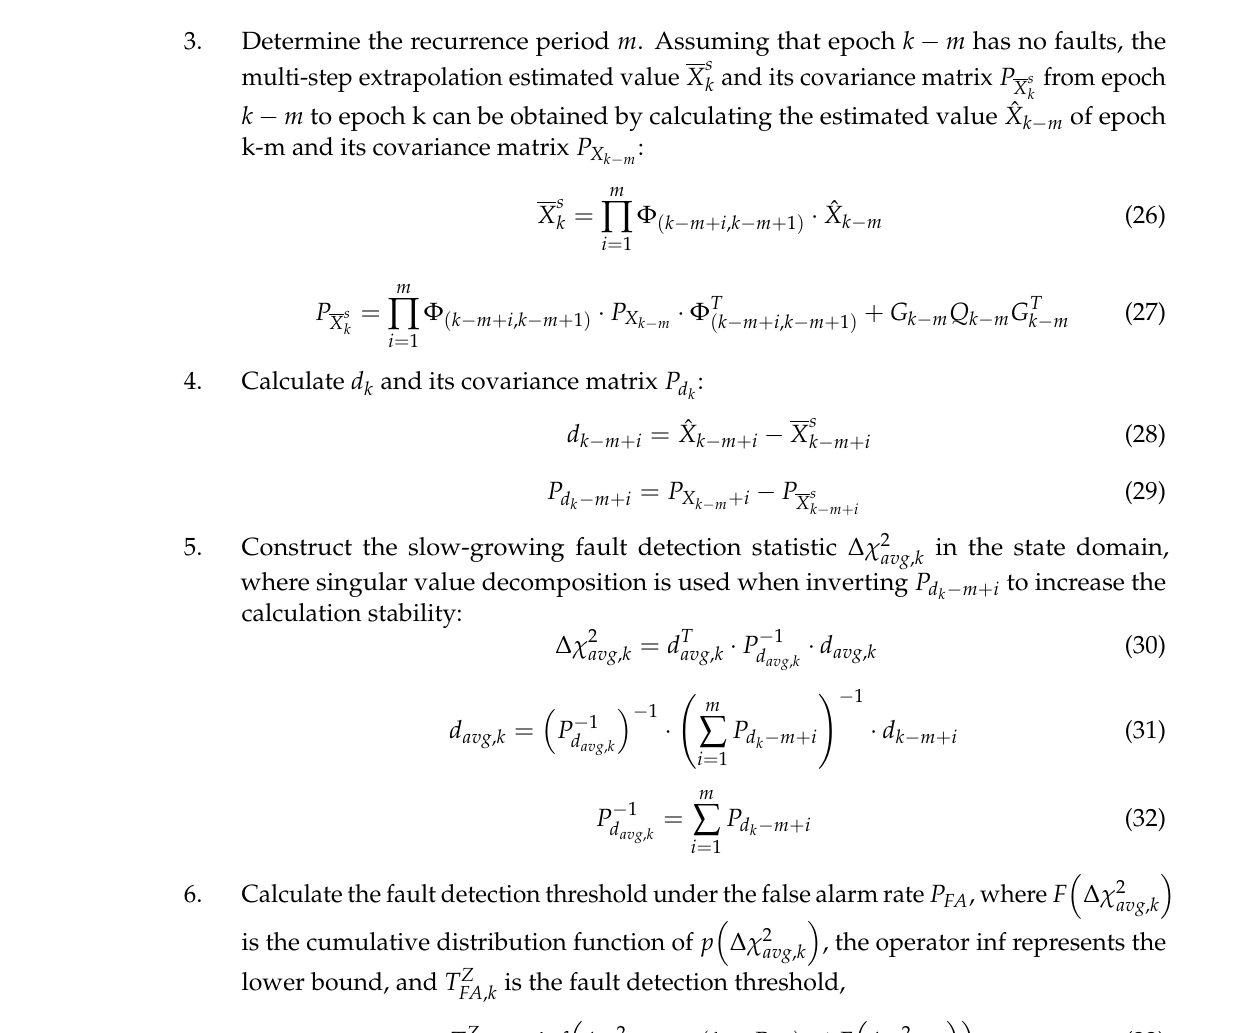
is the fault detection threshold, FA , k